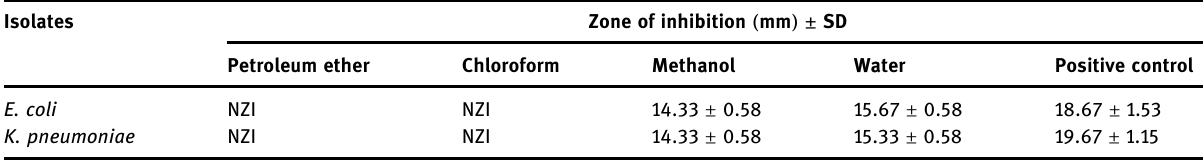
Table 1: Antibacterial activity of root extracts of P. indica against drug - resistant E. coli and K. pneumoniae at 5 mg/mL Isolates